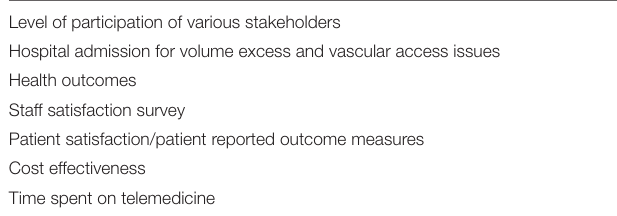
TABLE 2 | Measuring safety and quality indices of telemedicine in dialysis unit. Level of participation of various